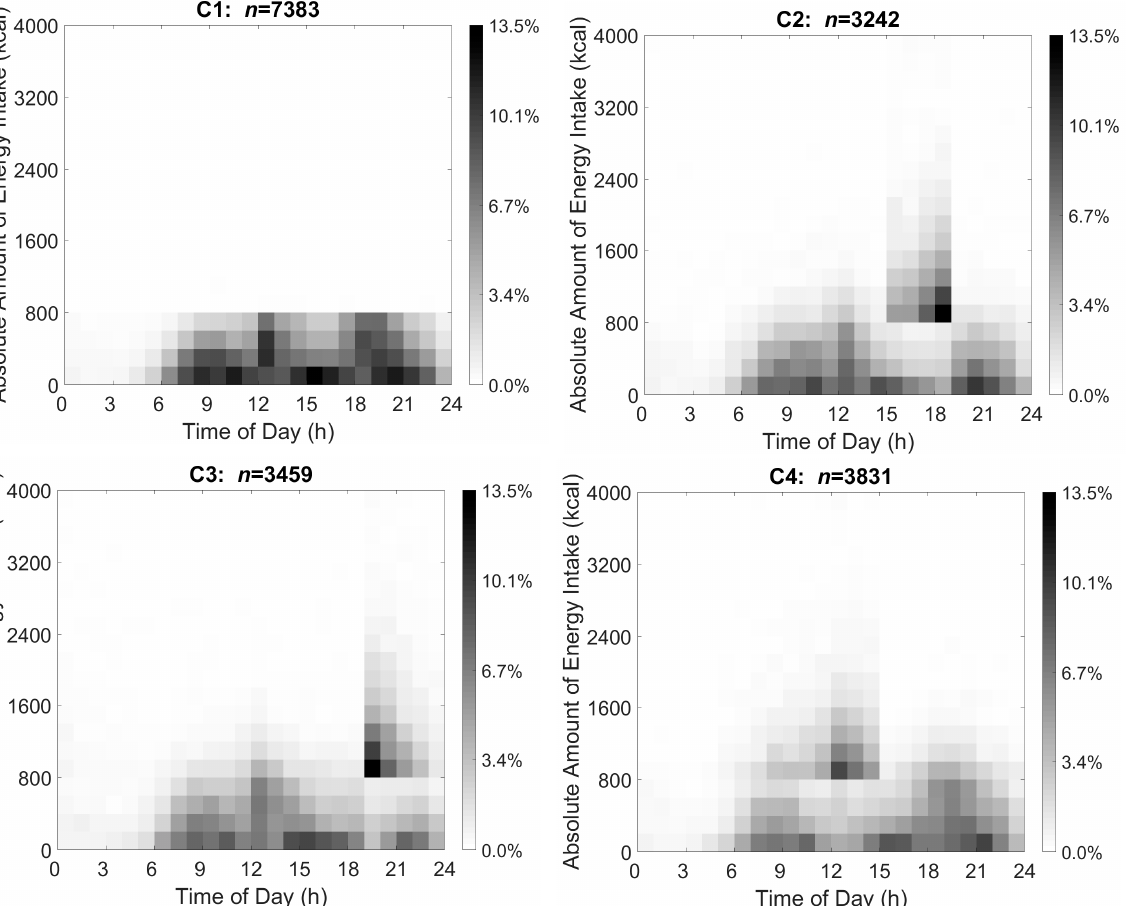
Figure 3. Energy intake heat maps representing four distinct TDPs generated based on the cut-off method for U.S. adults 20–65 years as drawn from NHANES 2007–2016 ( n = 17,915). Absolute energy intake ranges from 0 to 4000 kcal ( y -axis) while timing of intake ranges from 00:00 to 24:00 at hourly increments ( x -axis) for non-pregnant U.S. adults 20–65 years. The proportion of participants in each cluster reporting energy intake is shown through shading ranging from 0.0% to 13.5% of participants in the 4 TDP clusters. Darker shading represents a greater percentage of participants in the cluster reporting the same amount of energy intake at that time. C1, cluster 1; C2, cluster 2; C3, cluster 3; C4, cluster 4; TDP, temporal dietary pattern.